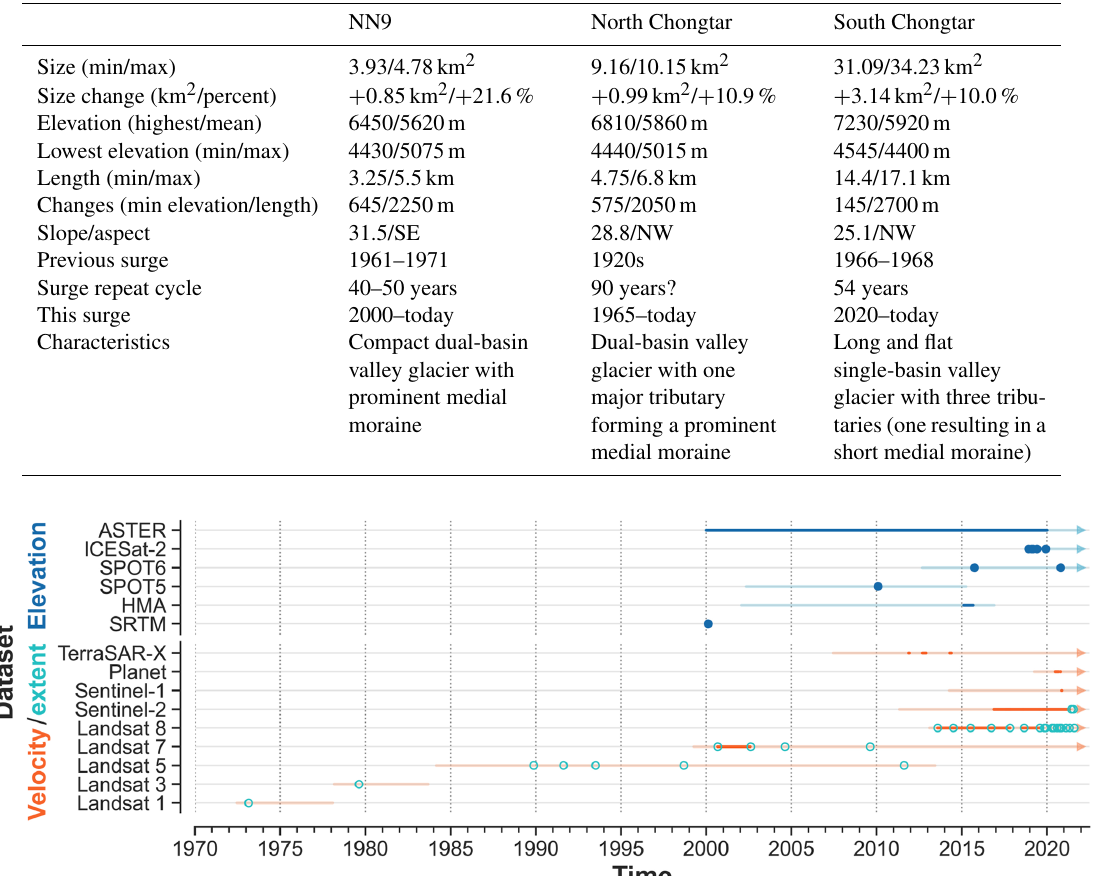
Table 1. Characteristics of the three investigated glaciers using outlines modified from the GAMDAM2 glacier inventory (Sakai et al., 2019) and digitized in this study. Elevations refer to the SRTM DEM. Values given for “min/max” refer to the minimum and maximum extent of a glacier shortly before and after a surge, respectively.